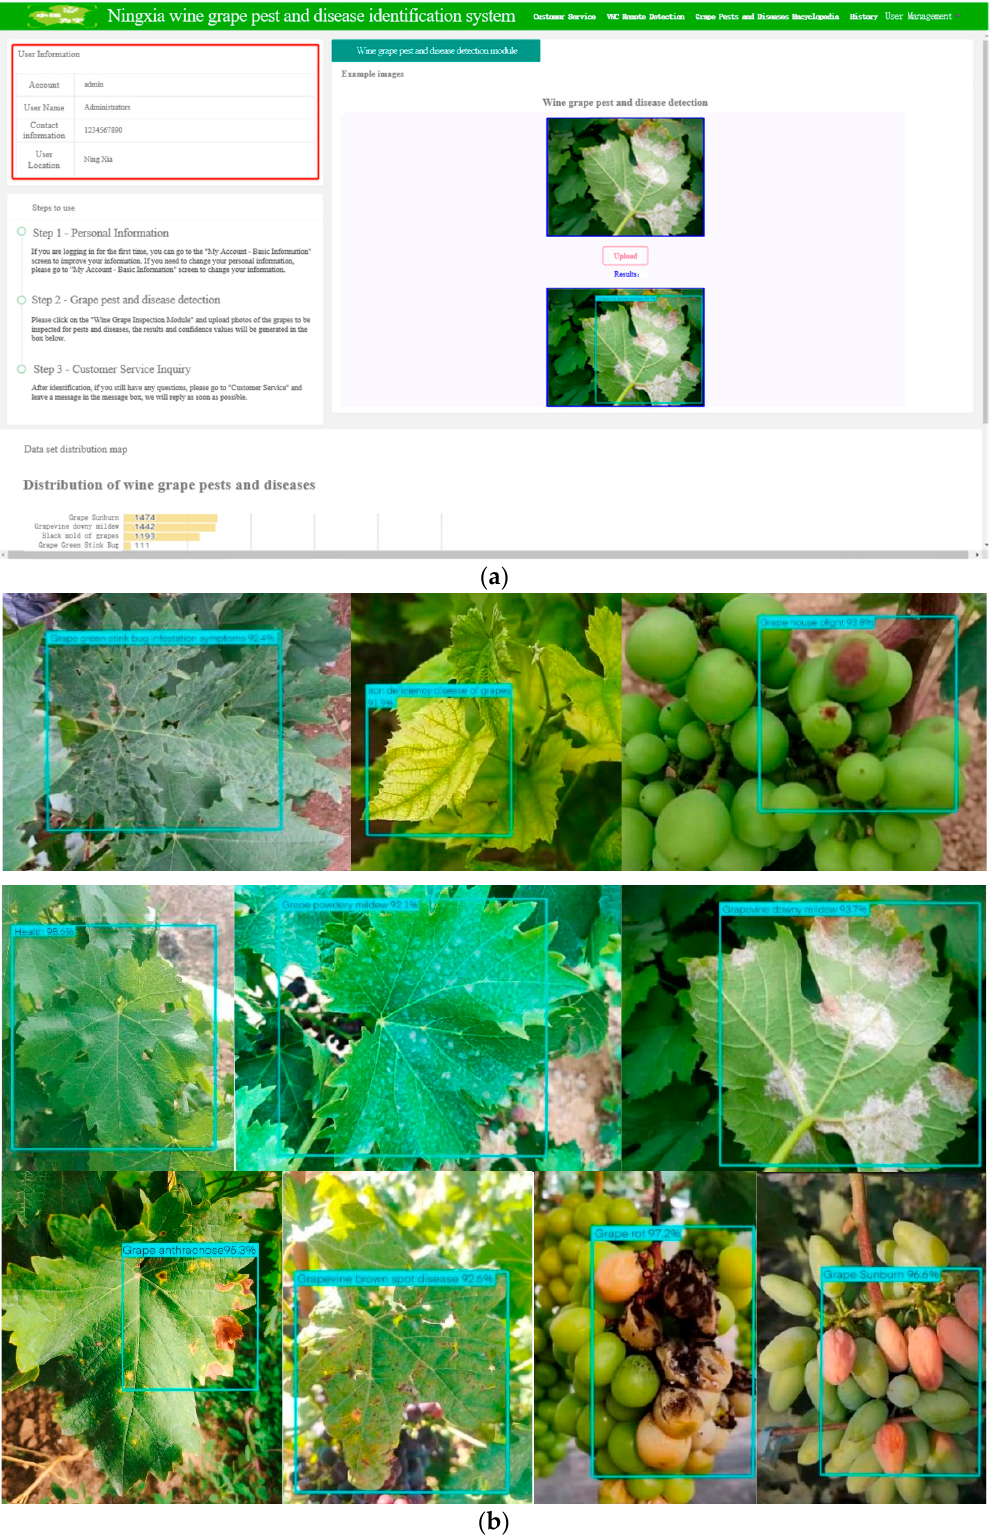
Figure 10. Functional testing of grape pest and disease detection on a web-based platform. ( a ) Web detection platform user interface. ( b ) Detection results of healthy leaf and 9 types of pest and disease grape leaves.